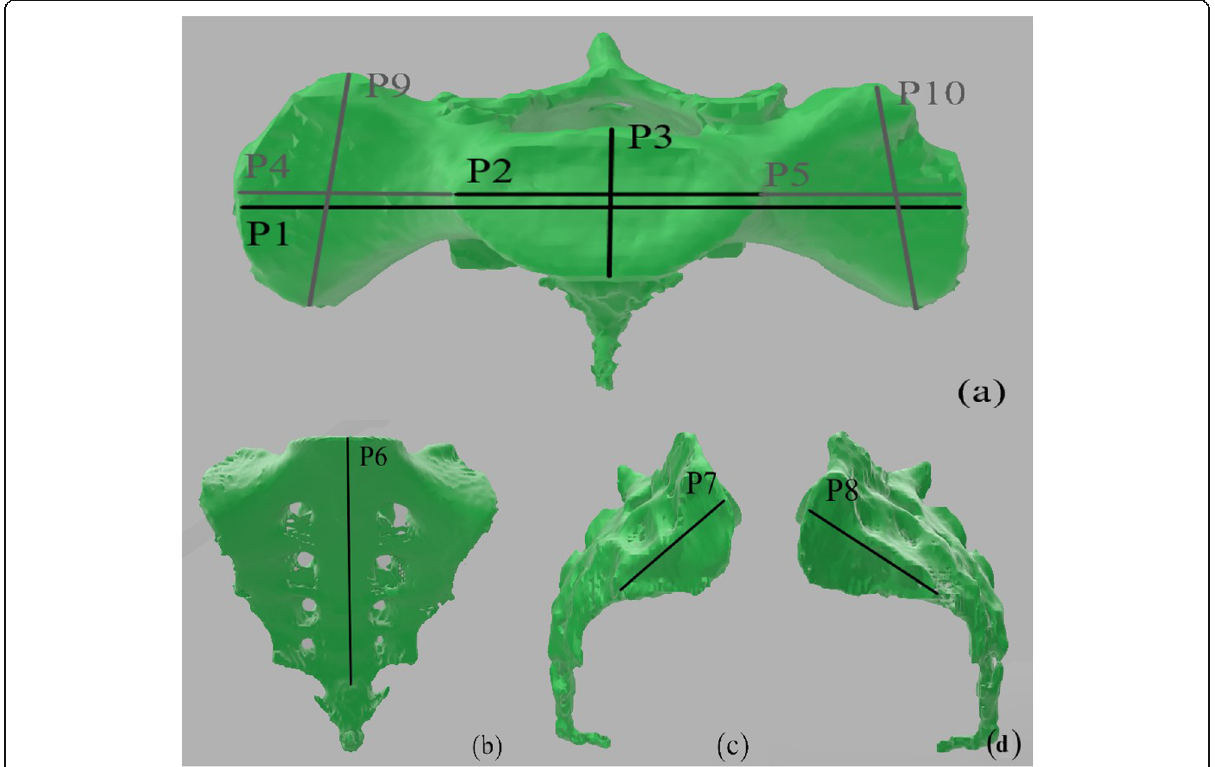
Fig. 1 Inter-landmark distances and parameters shown on the sacrum at superior view ( a ), anterior view ( b ), right lateral view ( c ) and left lateral view ( d ). Screenshots obtained from the Microsoft 3D Builder software (refer to Table 2 for the measurements of P1 – P10)